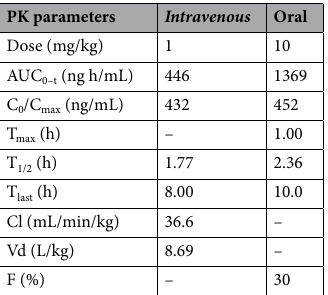
Table 5. Pharmacokinetic parameters of JBSNF-0000028 in mice following intravenous (1 mg/kg) and oral administration (10